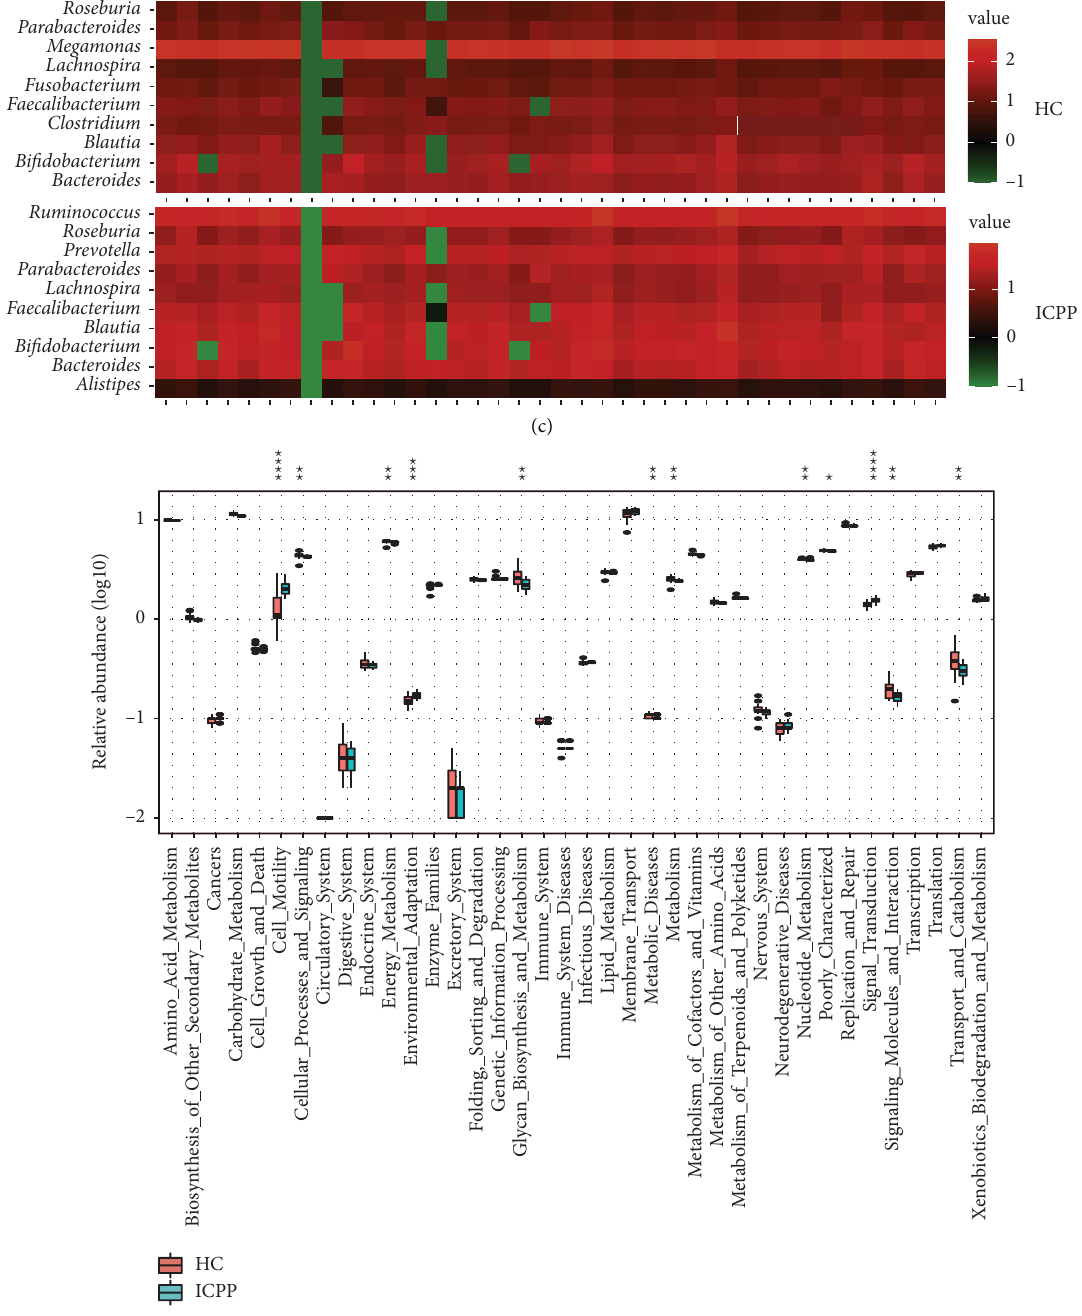
Figure 4: Te distribution of the predicted GM function in the PPP and healthy groups. In the heatmap, the contributions of the top 10 genera on 38 KEGG functional categories were detected in the PPP and HC groups (a), and ICPP and HC groups (c), respectively. Te deeper red square means the genera contribute to the functional category importantly, while the deeper green square means the functional category obtained less contribution from the genera. Te enriched pathways were compared between the PPP and HC groups (b), and the ICPP and HC groups (d) and shown in the box plot. Te asterisks indicated their P -values. ∗ , ∗∗ , ∗∗∗ , and ∗∗∗∗ stand for the P -value smaller than 0.05, 0.01, 0.001, and 0.0001,